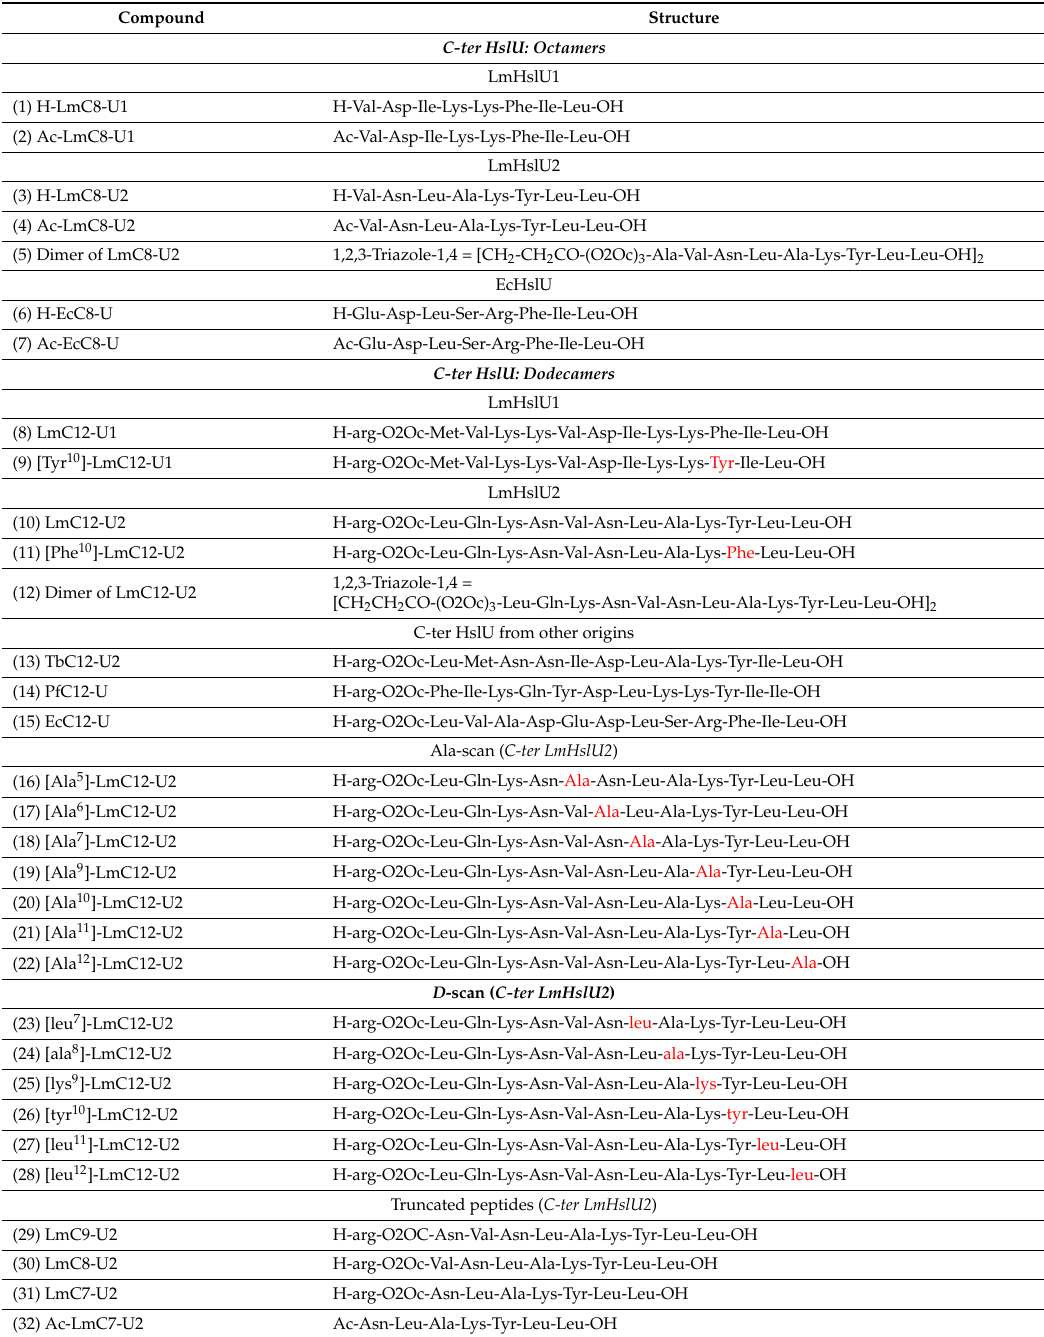
Table 1. Peptides used in this